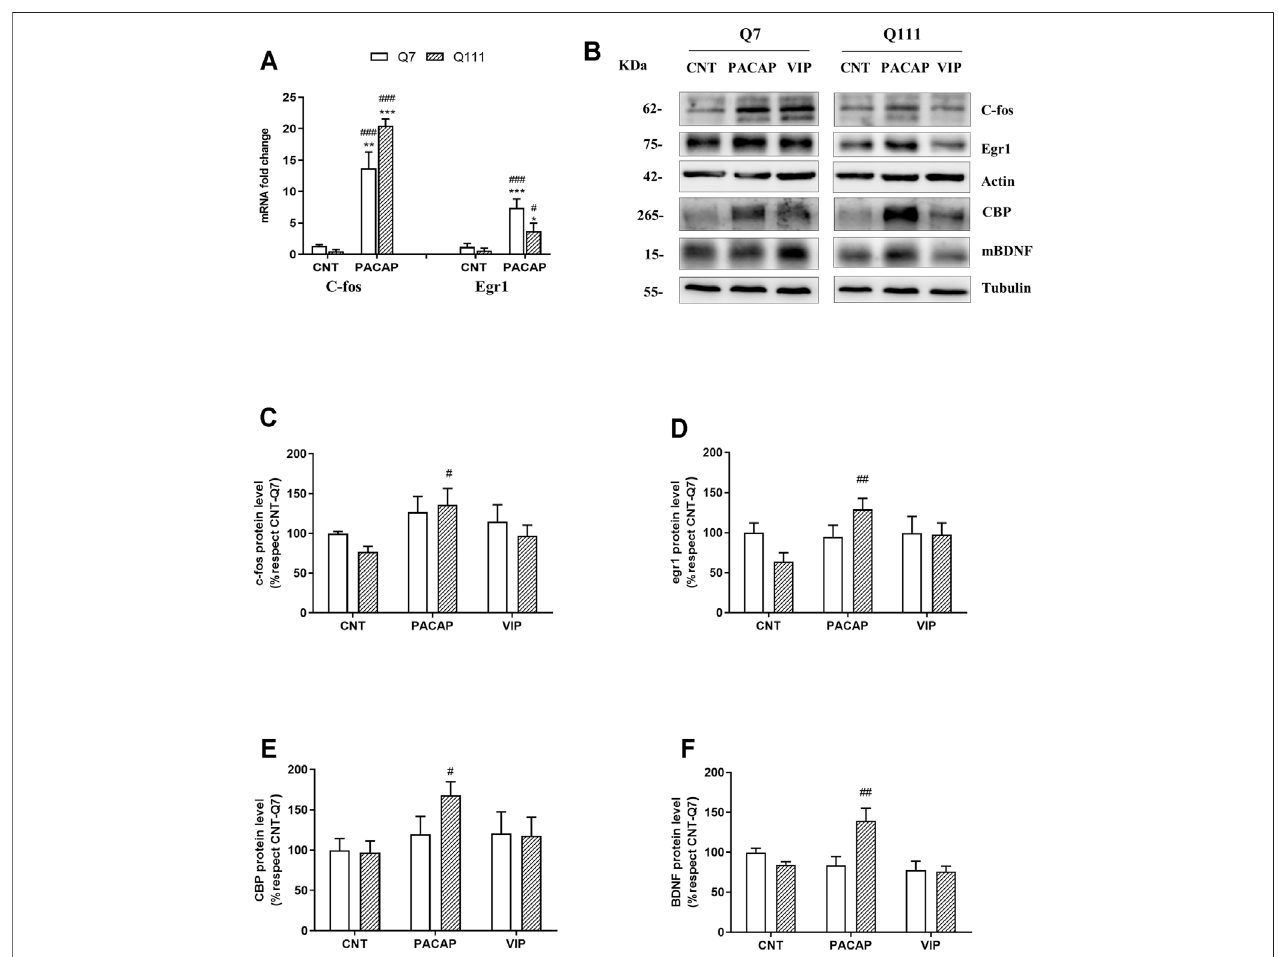
FIGURE 6 | PACAP but not VIP treatment increases c-fos, egr1, CBP, and BDNF levels in STHdhQ111/Q111 cells. STHdhQ7/Q7 (Q7) and STHdhQ111/Q111 (Q111) cells were treated with PBS (CNT), PACAP (10 − 7 M) or VIP (10 − 7 M) (A) After 1 h of PACAP addition, mRNA levels of c-fos and egr1 were analyzed using quantitative RT-PCR. The results (mean ± SEM; n (cid:1) 5) were normalized to GAPDH levels and are expressed as a percentage respect to CNT-Q7. (B) Protein levels of c-fos, egr1,andCBPwereanalyzed6 hafterPACAPaddition andBDNF24 hafterPACAPaddition. Representativeimmunoblotsareshown.Quanti fi cationof (C) c-fos, (D) egr1, (E) CBP, and (F) mBDNF was performed. Results (mean ± SEM; n (cid:1) 5) were normalized to the loading control tubulin or actin and are expressed as a percentage respect to CNT-Q7 cells. In all cases, data were analyzed by using two-way ANOVA followed by Tukey as post-hoc test. * p < 0.05, ** p < 0.01, *** p < 0.001, as compared to CNT-Q7 cells; # p < 0.05; ## p < 0.01, and ### p < 0.001 as compared to CNT-Q111